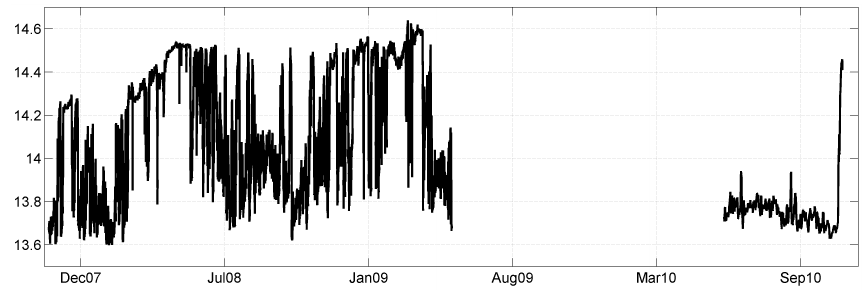
Fig. 14. θ time series in the Cretan Strait (at 850m).